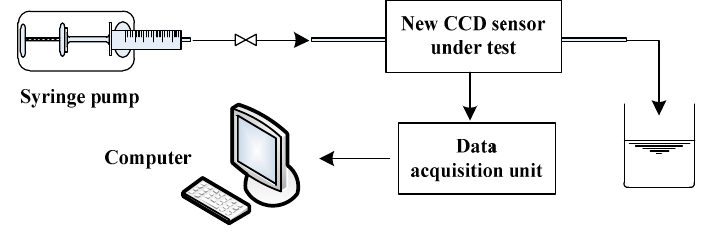
Figure 5. Experimental setup for conductivity measurement. Table 1. Parameters of the three new C 4 D sensors.